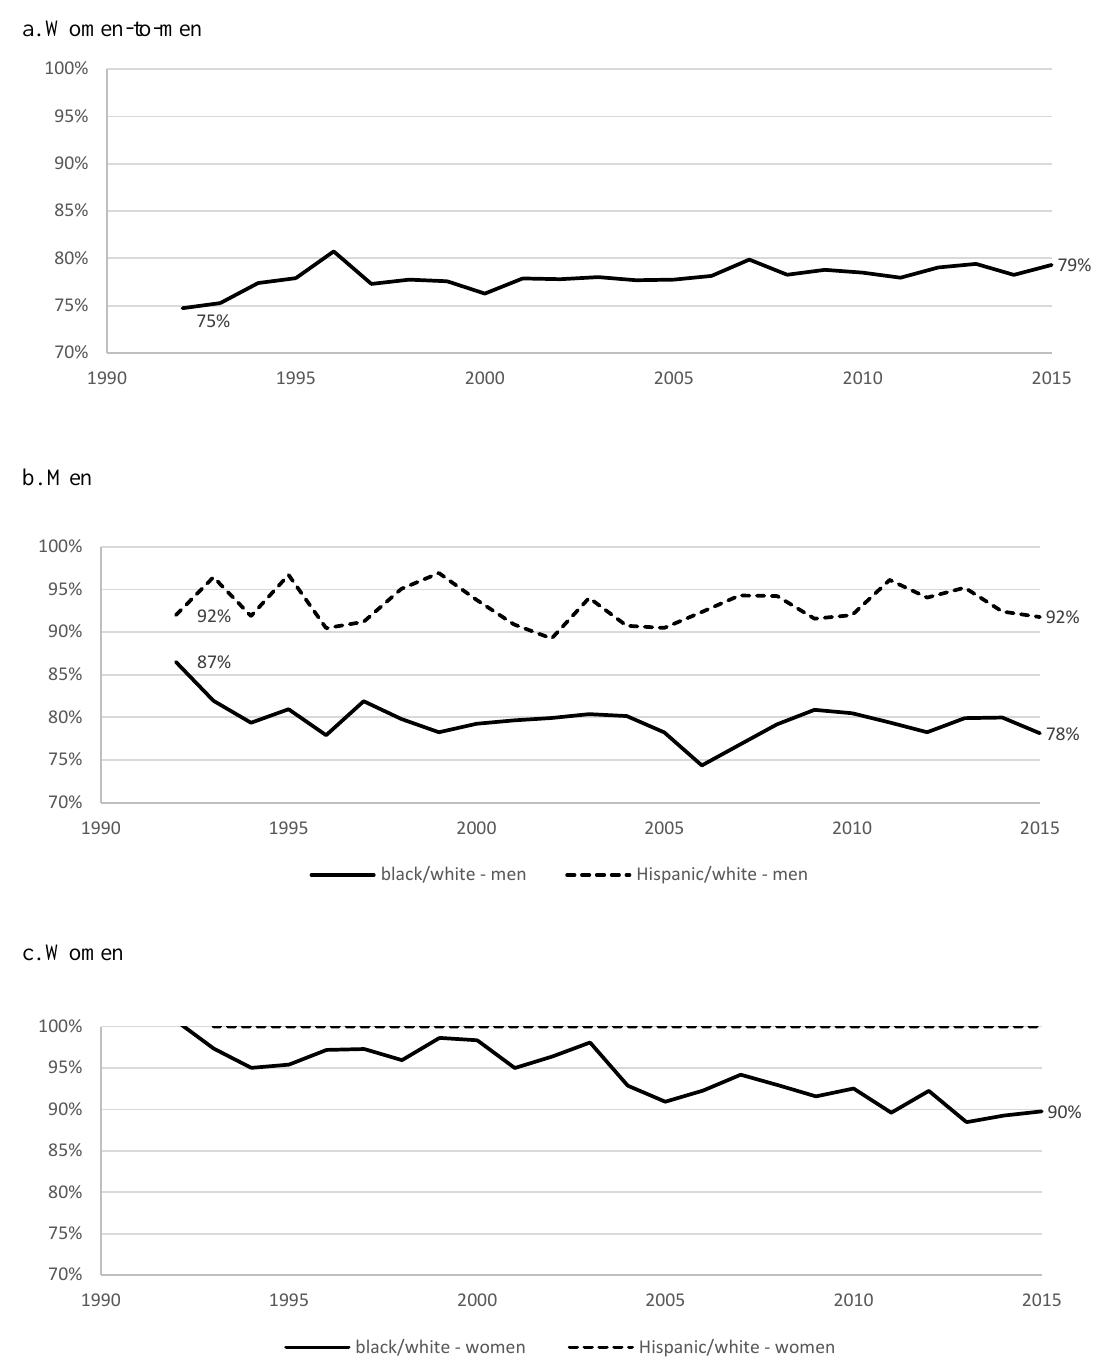
Figure 3: Women-to-men, black-to-white, and Hispanic-to-white annual health insurance costs,